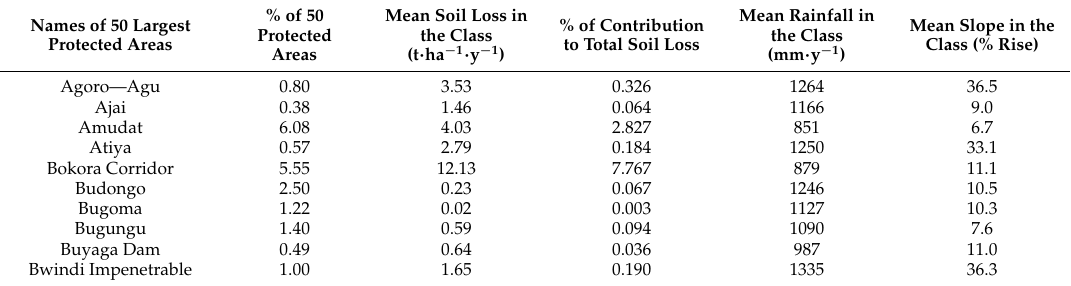
Table A2. Mean estimated soil loss rates in the 50 largest erosion-prone protected areas of Uganda, share of soil loss in the 50 total erosion-prone protected areas, mean annual rainfall intensity and mean